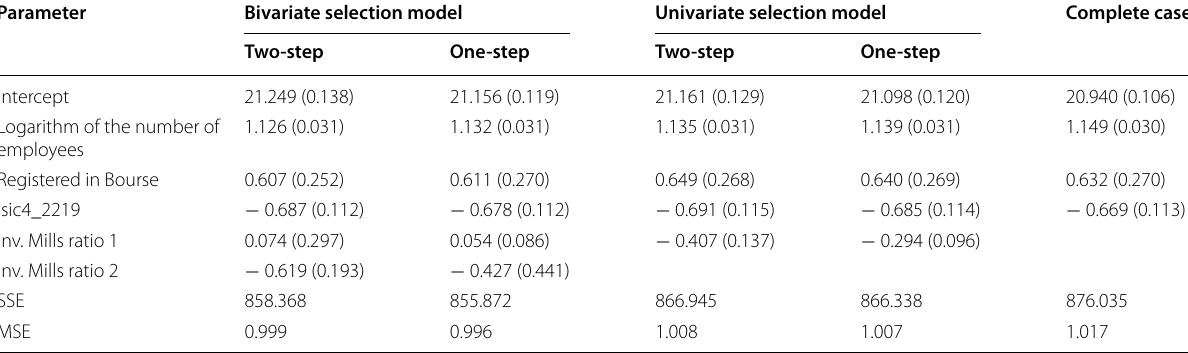
Table 8 Estimates of parameters with standard errors (in parentheses) in the main model using the bivariate selection model, the univariate selection model and the complete cases analysis